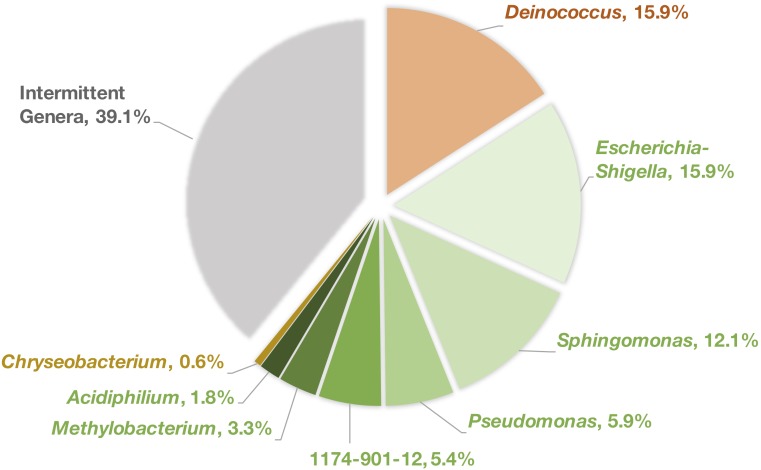
Percentage of reads attributed to each of the shared persistent genera. Colors refer to the corresponding phylum for each genus, orange = Deinococcus-Thermus, green = Proteobacteria, gold = Bacteroidetes, gray = all other intermittent bacterial genera.